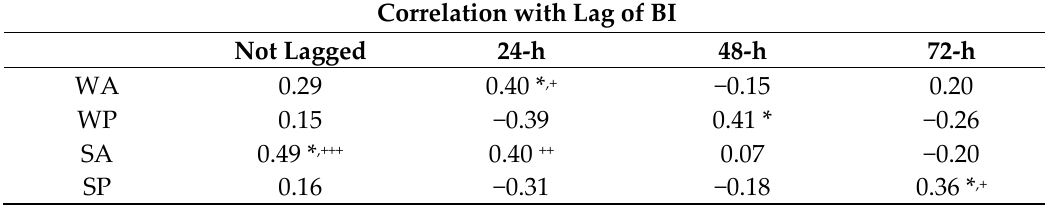
Table 3. Correlation of IRE and BI for each event and for a lag of BI to IRE by 24-h increments out to 72-h. WA: Weak Atlantic, WP: Weak Pacific, SA: Strong Atlantic, PS: Pacific Strong, AW: Atlantic Weak, * best correlation, and + , ++ , and +++ is correlation significant at least at the 90%, 95%, and 99% confidence level,